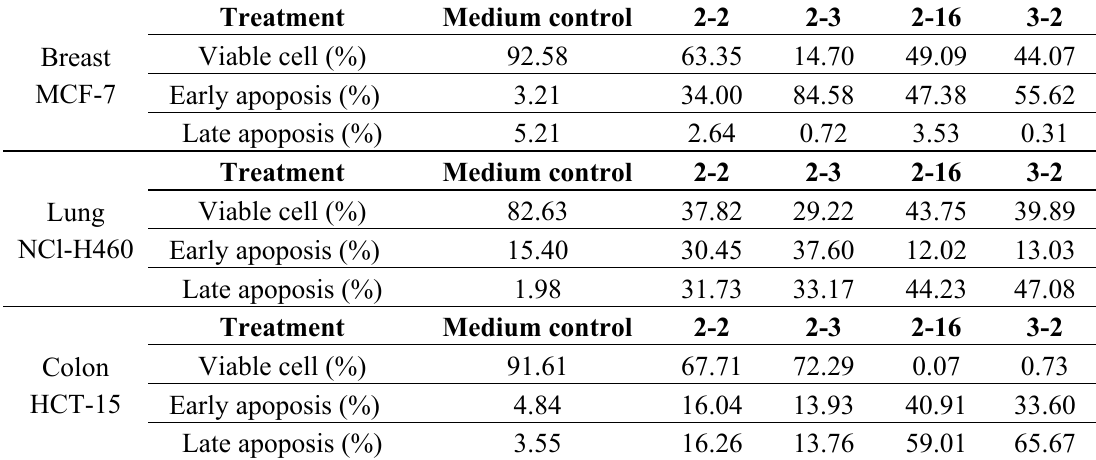
Table 2. The apoposis results against breast MCF-7, lung NCl-H460 and colon HCT-15 cancer cell lines after 48-hour